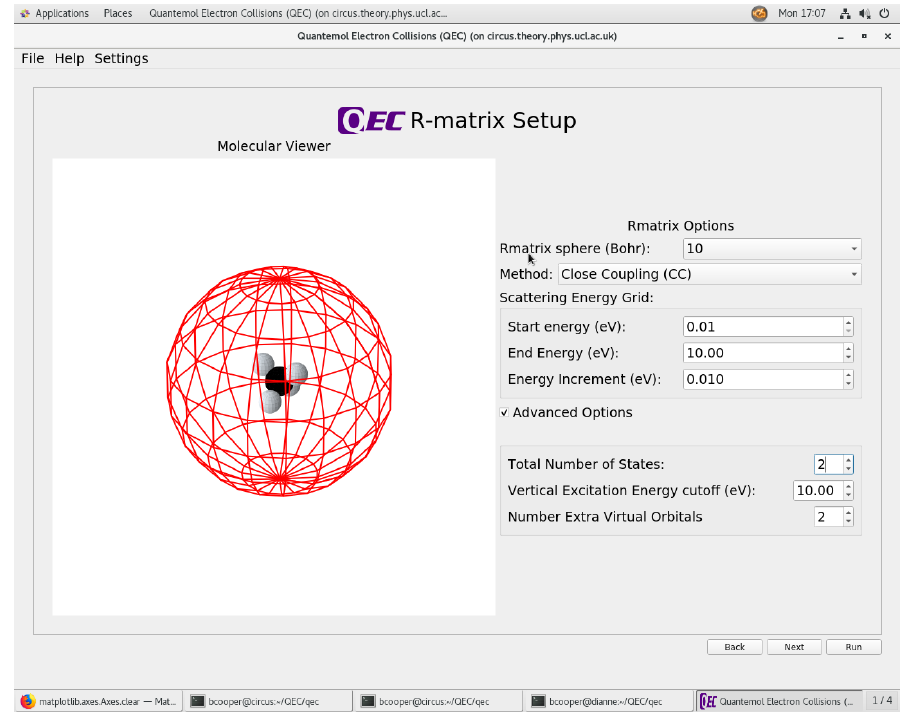
Figure 3. Screenshot of the page in the QEC GUI which set the parameters for the scattering